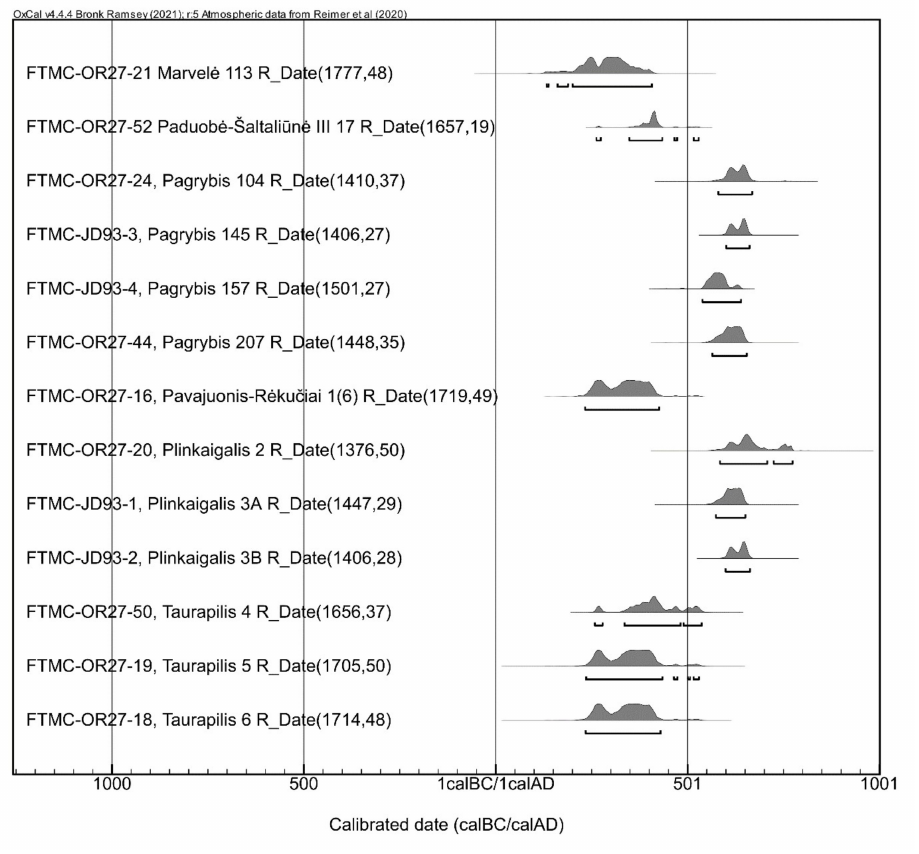
Figure 3. Calibrated 14 C